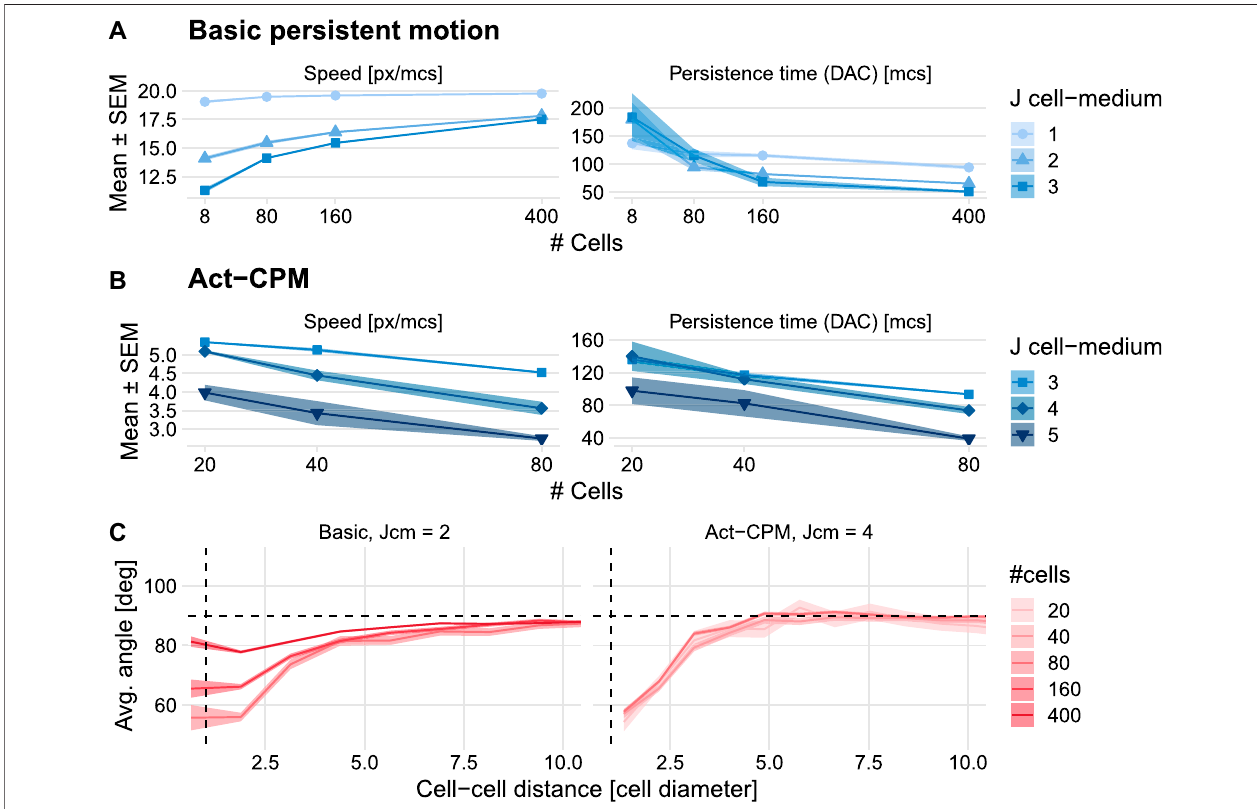
FIGURE4| EffectofcelldensityoncellspeedandpersistencesimulatedusingexistingCPMpersistence models. (A,B) Instantaneousspeedandpersistencetime asafunctionofcelldensityforsimulationswiththebasicpersistencemechanismimplementedintheMorpheusPersistentMotionplugin (A) andtheMorpheusActmodel implementation (B) . Persistence time was in both cases fi tted from the DAC in model simulations. (C) Stream formation in both models. Horizontal dashed lines denote theoretically expected average angle, vertical dashed lines denote approximate cell